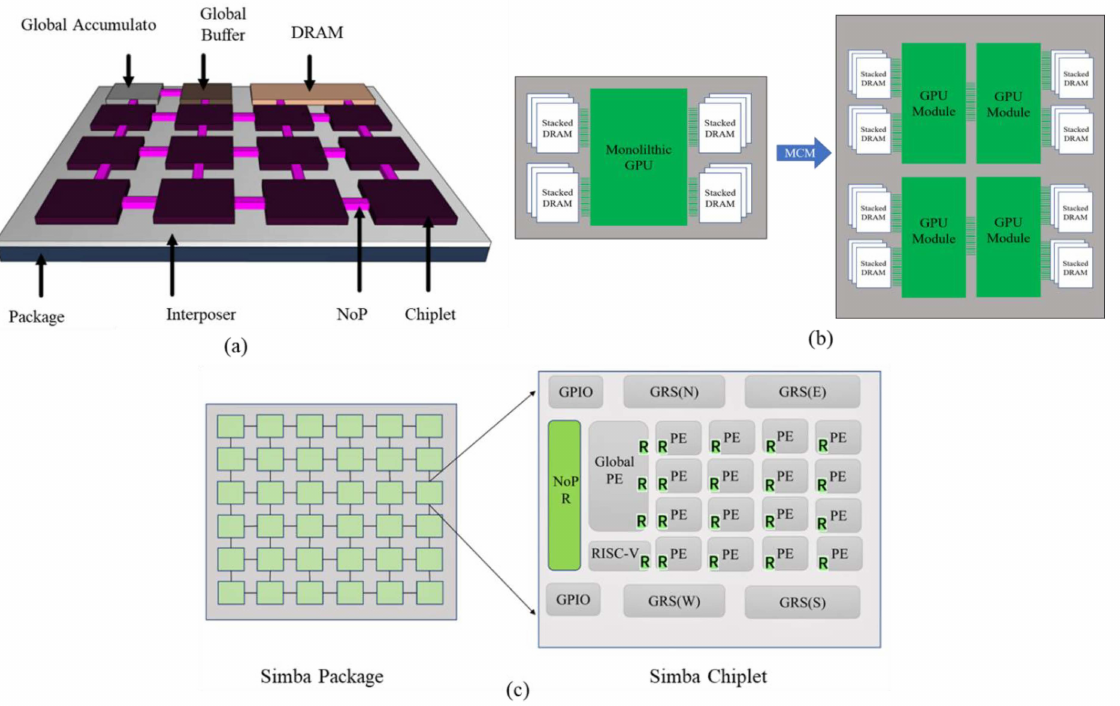
Figure 3. ( a ) PIM architecture based on Chiplet; ( b ) Chiplet-based design GPU (reprinted